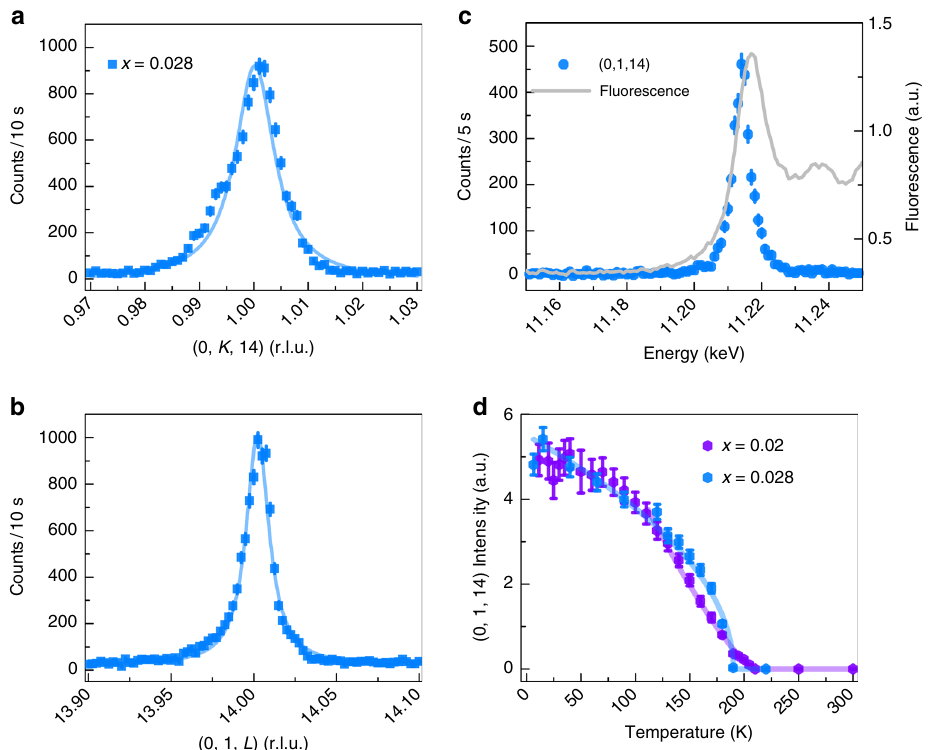
Fig. 2 REXS data in the polarization fl ipped σ - π channel of sample x = 0.02 (purple) and x = 0.028 (blue). a and b show K and L scans through the (0, 1, 14) position at T = 10 K respectively. c Energy dependence of the (0, 1, 14) peak at 10 K and its comparison to the Ir L 3 fl uorescence line. d Temperature dependence of the (0, 1, 14) peaks for both samples. Data have been normalized to appear on the same scale. The solid lines in ( a , b , d ) are the fi ts to the data. Data are collected at the energies of 11.217 and 11.215 keV for the x = 0.02 and x = 0.028 sample, respectively. All vertical error bars in the fi gure represent 1 standard deviation (s.d.) statistical